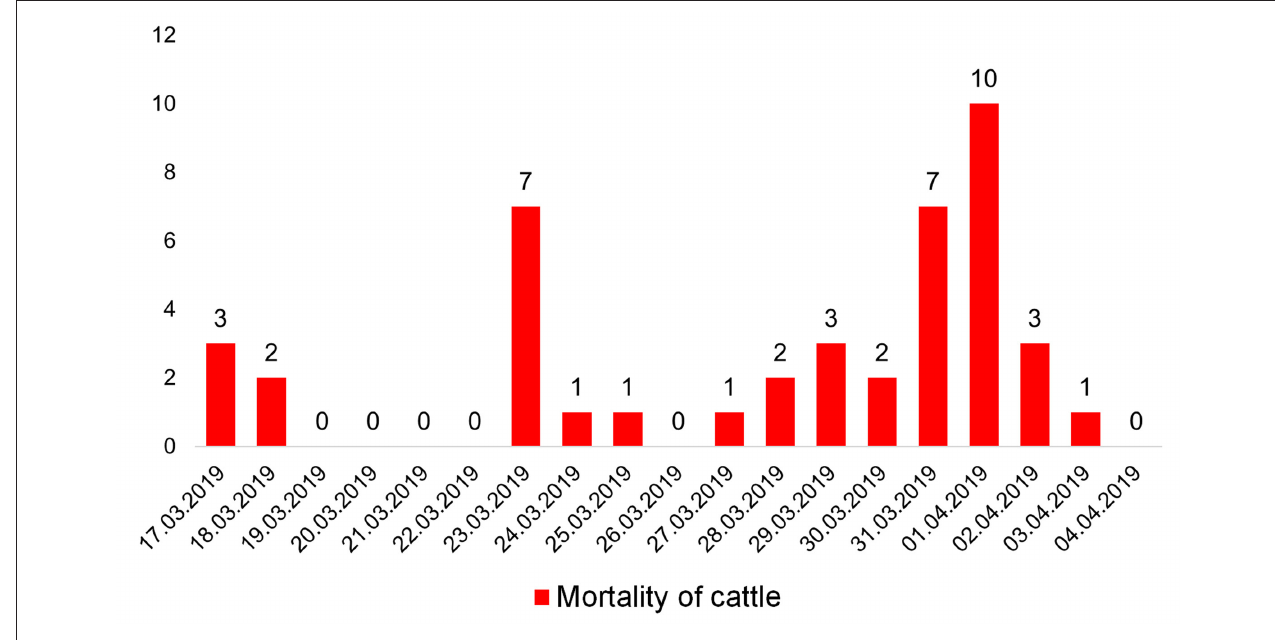
FIGURE 1 | Animal deaths from 17 March to 04 April 2019.